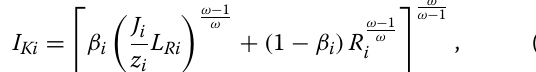
non-physical investments, I K , i , are determined by labor in research, L Ri , non-labor inputs in research ( R i ), and the number of intermediate goods, J i , following